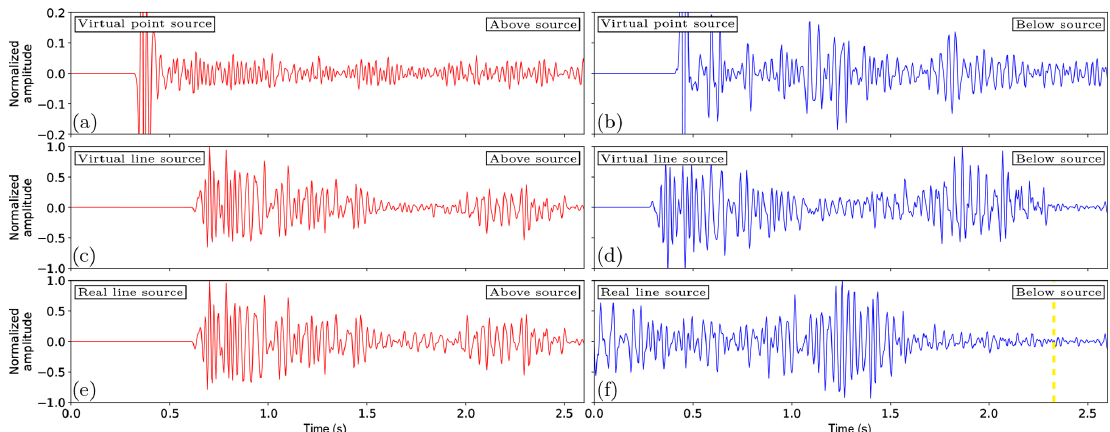
Figure 13. Traces of receivers in the subsurface at two locations, extracted from Fig. 12. In the left column, the receiver is located above the source and corresponds to the red dot in Fig. 12a, and in the right column it is located below the source and corresponds to the blue dot in Fig. 12a. (a–b) Homogeneous wave field in the subsurface, retrieved for virtual receivers and a virtual double-couple source inclined at − 20 ◦ using Eq. (19). (c–d) Similar to (a–b) for a line source of double-couple sources with random amplitudes inclined at − 22 . 4 ◦ using Eq. (21). (e–f) Similar to (c–d) using a superposition of double-couple sources with random amplitudes using Eq. (22). The yellow line in (f) indicates the time after which the correct signal is retrieved. All wave fields had their source wavelets reshaped to a 30Hz Ricker